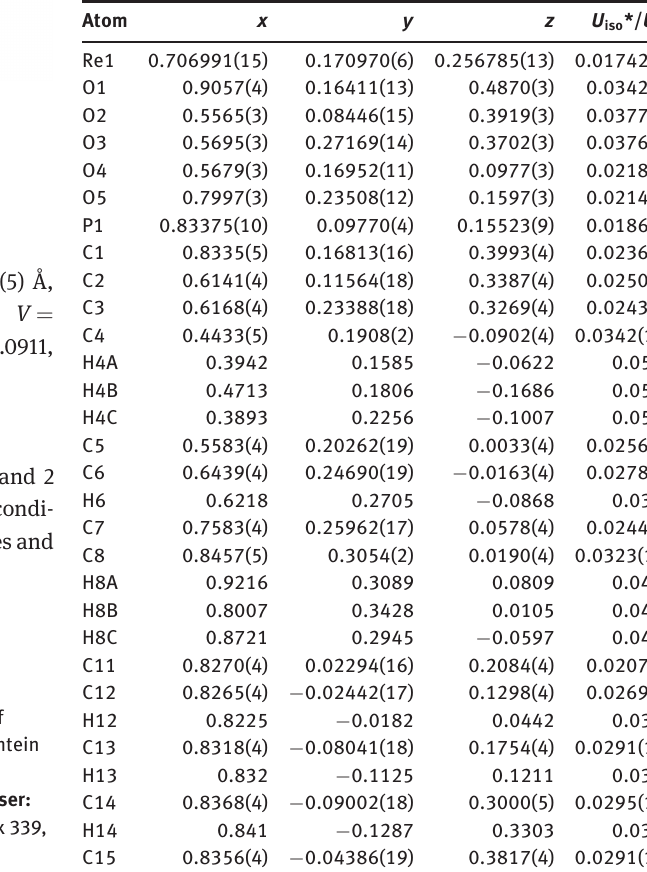
Table 2: Fractional atomic coordinates and isotropic or equivalent isotropic displacement parameters (Å 2